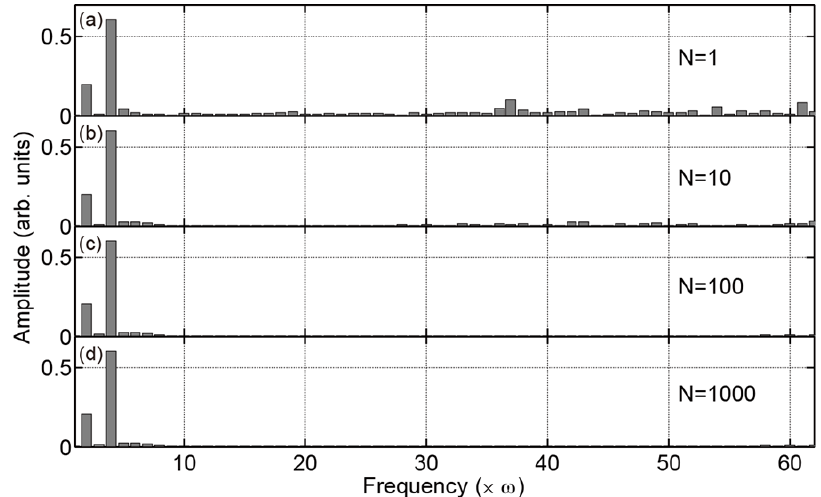
Figure 5. ( a )–( d ) Amplitude of each frequency component of the experimental data after the background subtraction for different averaging numbers N . We repeat the measurements